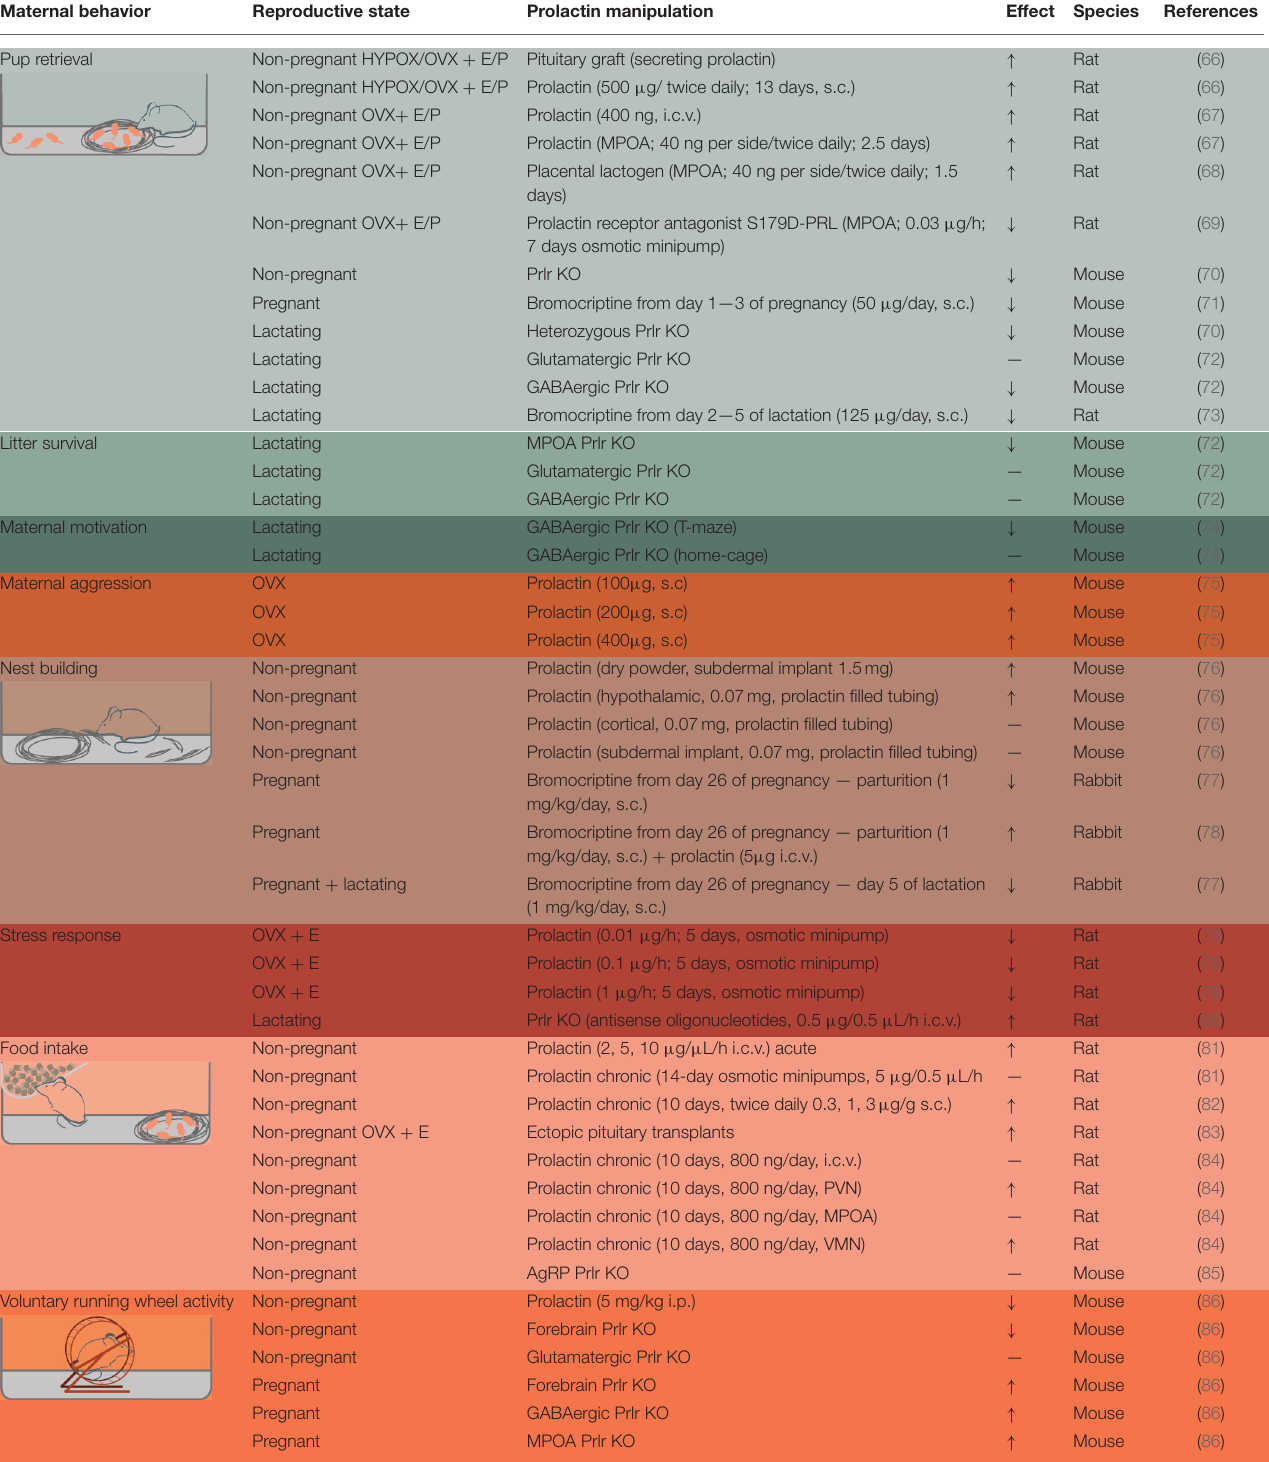
TABLE 1 | Evidence for prolactin regulating specific aspects of maternal behavior. Maternal